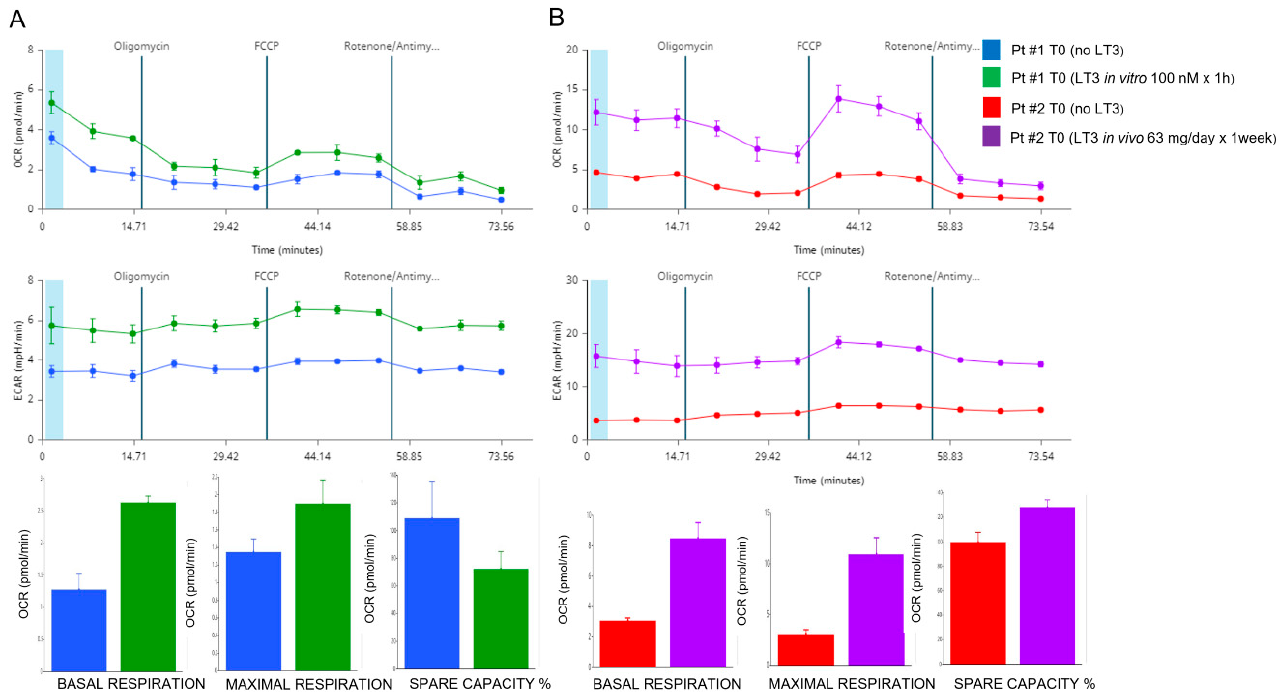
Figure 5. Mitochondrial respiration in two COVID-19 patients in the pilot study. Seahorse analysis of oxygen consumption rate (OCR) and extracellular acidification rate (ECAR) performed on PBMCs obtained from COVID-19 patients with NTIS and treated in vivo and in vitro with LT3. ( A ) The analysis of the PBMCs from patient 1 before (in blue) and after (in green) in vitro treatment with 100 nM of LT3 for 1 h. The profiles of oxygen consumption and extracellular acidification rates are reported in the upper panels; the graphs showing basal and maximal OCR and spare capacity are reported in the lower panels. ( B ) The analysis of the PBMCs from patient 2 before (in red) and after (in purple) in vivo treatment with 63.9 µg/die of LT3, given orally for one week. The profiles of oxygen consumption and extracellular acidification rates are reported in the upper panels; the graphs showing basal and maximal OCR and spare capacity are reported in the lower panels. OCR was measured continuously throughout the experimental period at baseline and in the presence of the indicated drugs: 1 µM oligomycin, 1 µM FCCP, and 1 µM rotenone with 1 µM antimycin A (R + A).